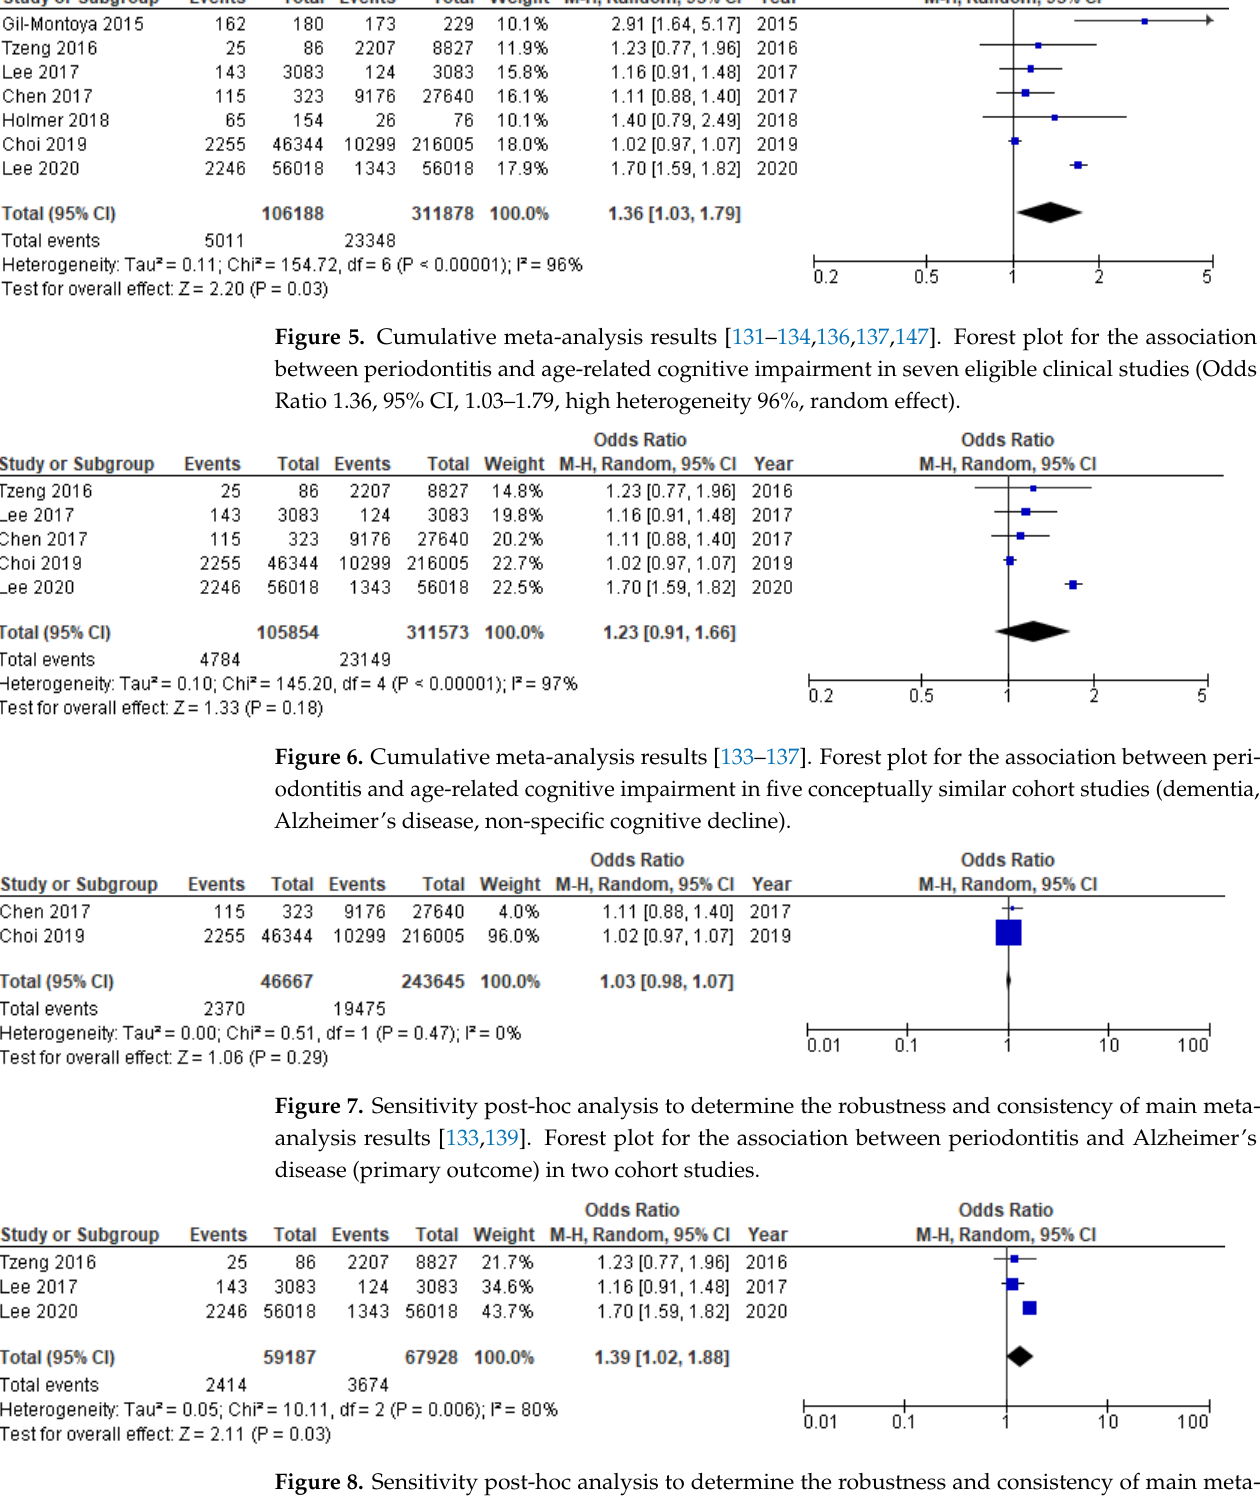
Figure 9 . Funnel scatter plot assessing publication bias for seven eligible clinical studies. Potential evidence of publication bias. A graphical representation of the effect estimates from seven studies against measure of each study’s size/precision. 4. Discussion This multifaceted systematic review aimed to determine whether periodontitis is a potential risk factor for developing ACI by evaluating the existing evidence. Qualitative and quantitative analysis of literature revealed an apparent moderate association between periodontitis (all stages, mild/moderate/severe) and ACI, including the most common forms of cognitive decline: Alzheimer’s disease, vascular dementia, and mild cognitive impairment. This link was established for dementia and Alzheimer’s disease in 13 clinical studies with different protocol, design, sample size, study duration, and various con- founders. However, causality cannot be inferred due to the moderate and, in some cases, low quality of the study designs. Noteworthy, the obtained study results can be hindered by multiple problems, in- cluding: (1) the multi-factorial etiology of PDS and ACI, (2) the wide range of risk factors, (3) different diagnostic criteria for PDS and ACI, (4) the chronic nature of both conditions, which requires longitudinal studies, and (5) ethical aspects related to interventional re- search projects. SRs of the association between periodontitis and neurological conditions